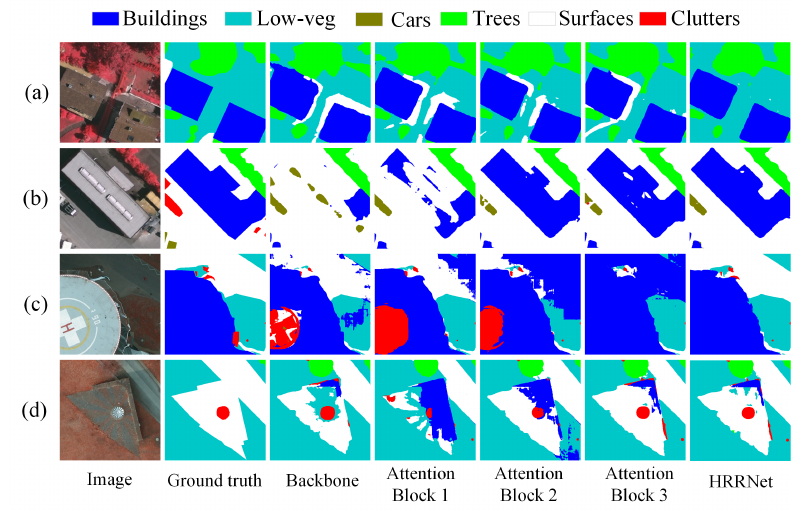
Figure 4. On the basis of backbone, the segmentation result map after adding the attention block in sequence. Rows ( a , b ) are the selected results on the Vaihingen dataset. Rows ( c , d ) are the selected results on the Potsdam dataset.